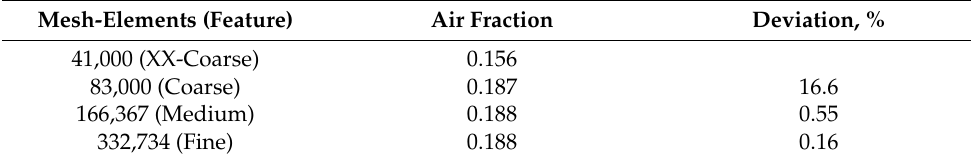
Table 1. Mesh dependency